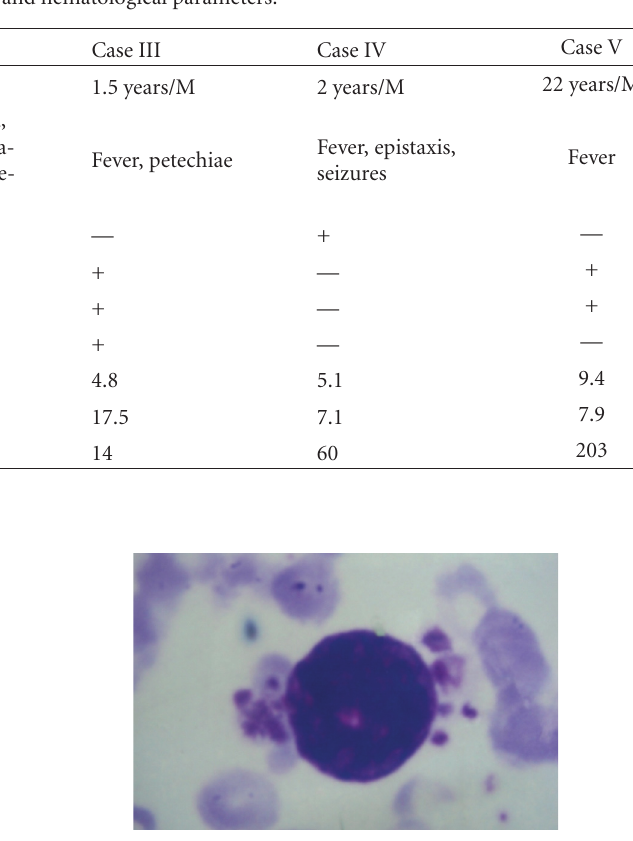
Table 1: Clinical features and hematological parameters.